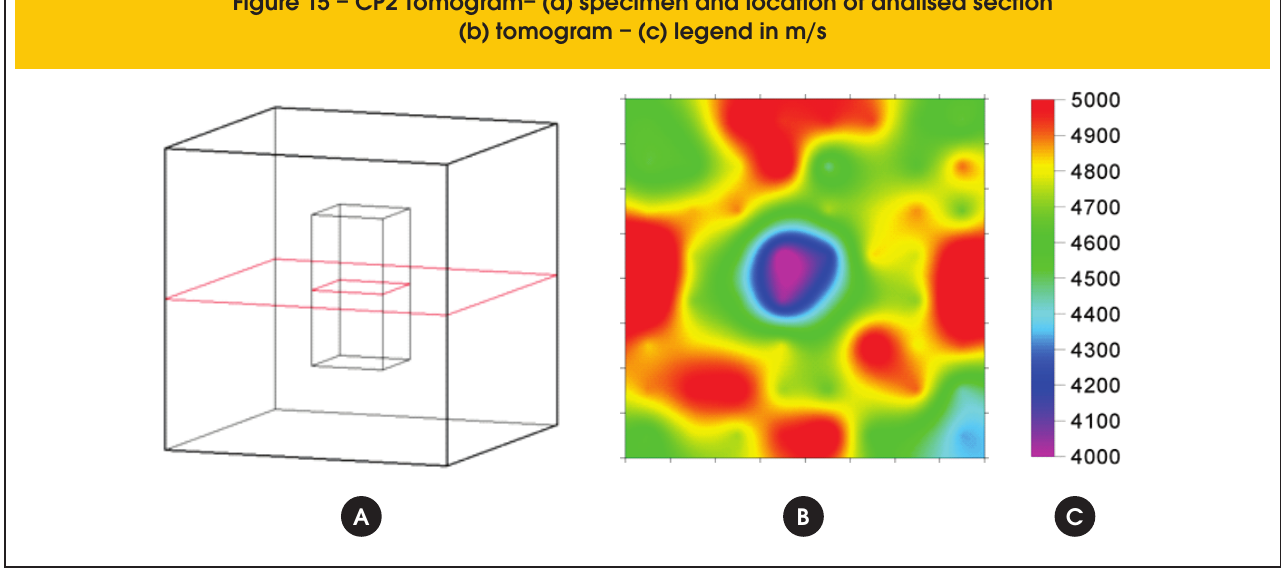
Figure 15 – CP2 Tomogram– (a) specimen and location of analised